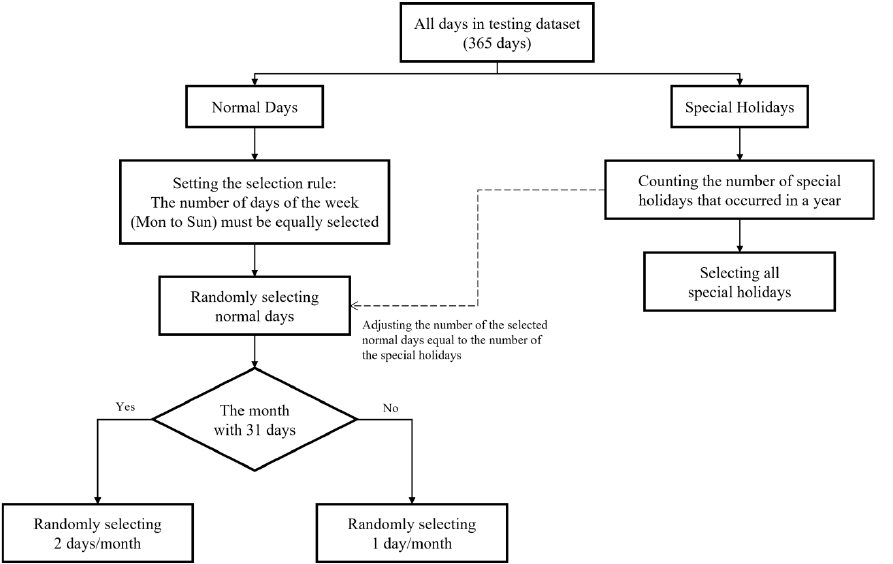
Figure 2. The process of randomly selecting the target forecast date.